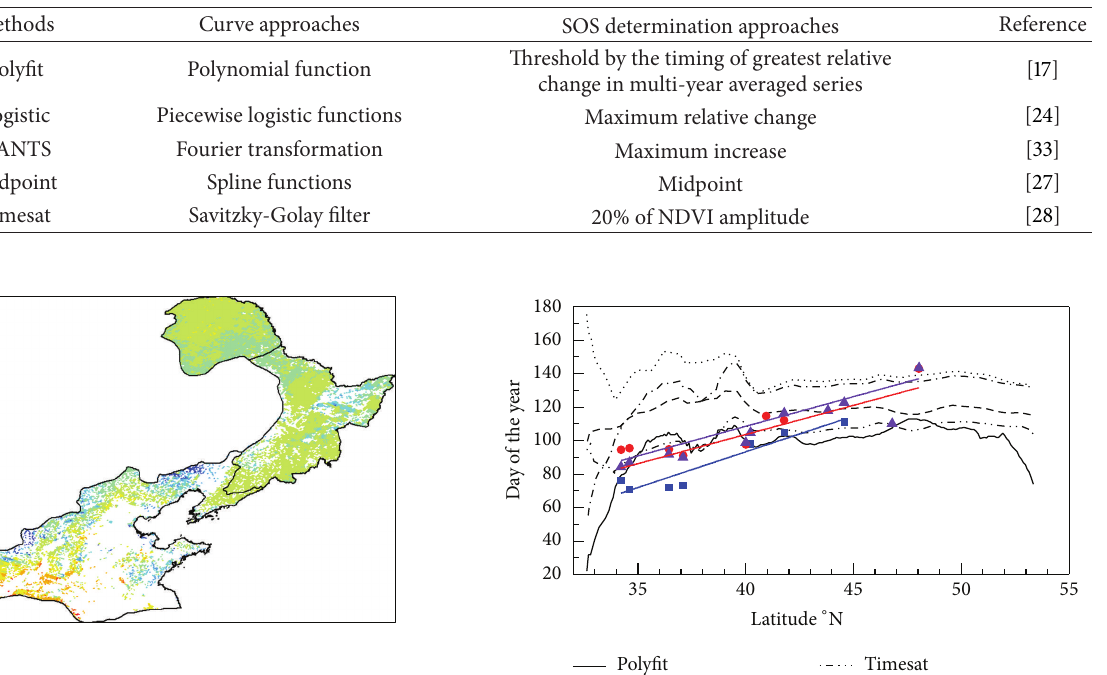
Table 2: Summary of five methods in estimating SOS from satellite data. The number for each method is defined for the purpose of distinguishing the satellite-derived SOS measures from ground phenophases in Table 1.